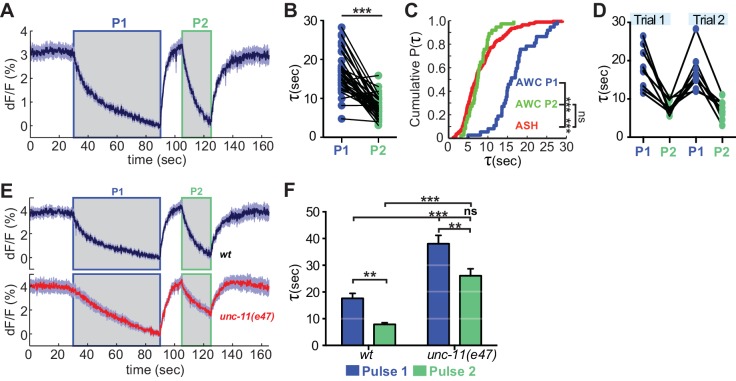
Recent neural activity modulates AWCON VGLUT-pH retrieval.(A) Average AWCON VGLUT-pH response to two successive odor stimuli, applied for 60 s (P1) and 20 s (P2). n = 39 (13 animals, three trials each). (B) Time constants from single-term exponential fits to P1 and P2 from (A) performed on the initial 20 s of the decay for each pulse. n = 37 (13 animals, 2–3 trials each). Paired t-test, ***p<0.0001. (C) Cumulative distribution plot of time constants for AWC P1, AWC P2, and ASH VGLUT-pH decays. AWC P1 and AWC P2 data from (B) and ASH data from Figure 6D. Kruskal-Wallis and Dunn’s test for multiple comparisons, ***p<0.0001, ns p=0.1. (D) Time constants for P1 and P2 from two consecutive trials of the stimulation protocol in (A) (n = 8 animals, 70 s between trials). (E) Average AWC VGLUT-pH signals in wt and unc-11(e47) mutants. wt n = 21 (7 animals, three trials each). unc-11(e47) n = 25 (9 animals, three trials each) (two non-responding trials removed). (F) Average time constants from single exponential fits (initial 20 s of decay) of data in (E). wt n = 21 (7 animals, three trials each). unc-11(e47) n = 22 (8 animals, 2–3 trials each). Two-way ANOVA, ***p<0.0001, **p<0.008, ns (p=0.07). Gray areas marks stimulus periods. Shading and error bars indicate S.E.M. ns = not significant.10.7554/eLife.31234.020Figure 7—source data 1.Source data for Figure 7.